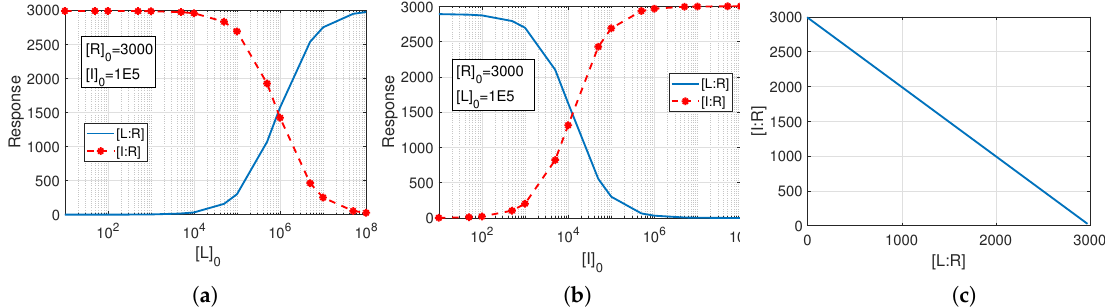
Figure 7. The steady-state response of (29): ( a ) versus the initial concentration of the ligand when the inhibitor’s initial concentration is constant; ( b ) versus the inhibitor’s initial concentration when the initial concentration of the ligand is fixed; and ( c ) the receptor’s response to the inhibitor versus its response to the ligand.